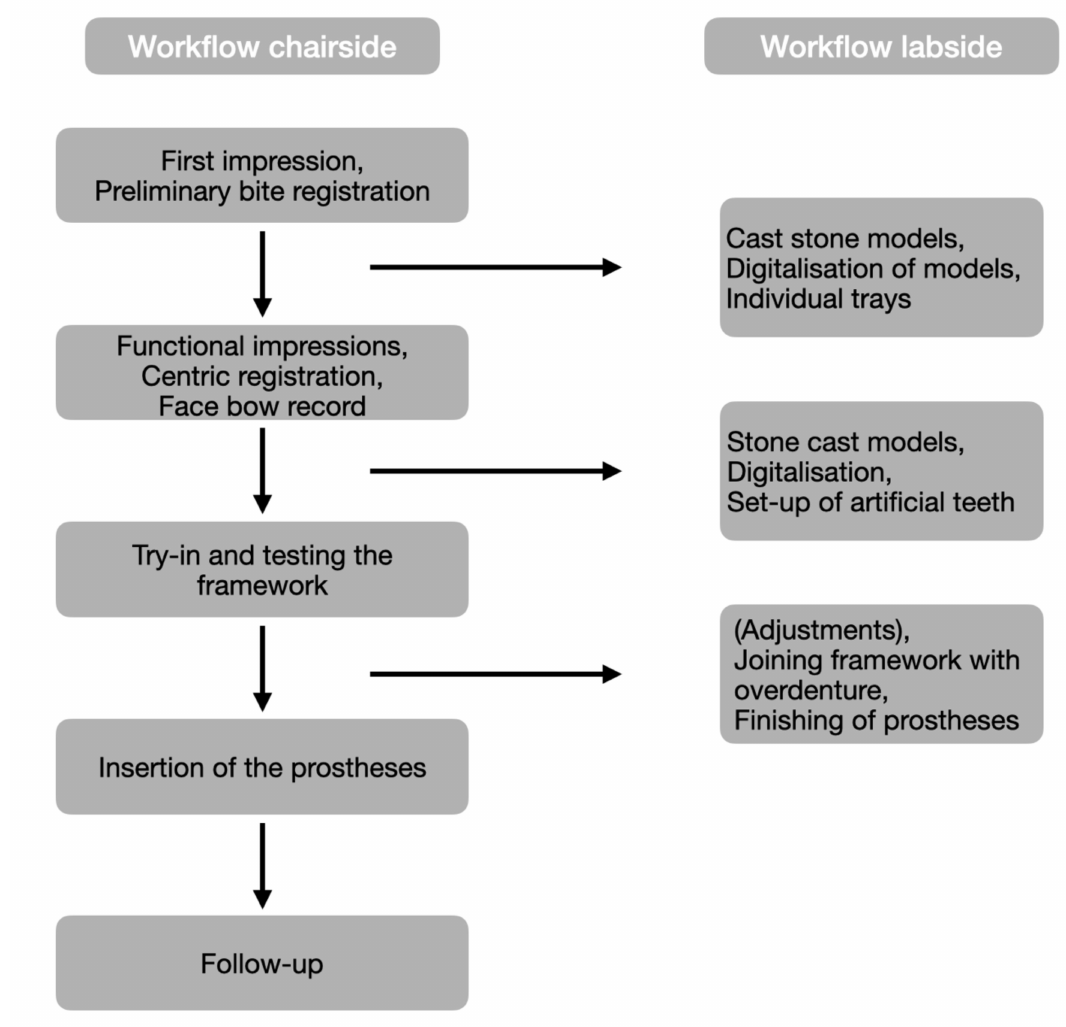
Figure 22. Flow-chart of the combined